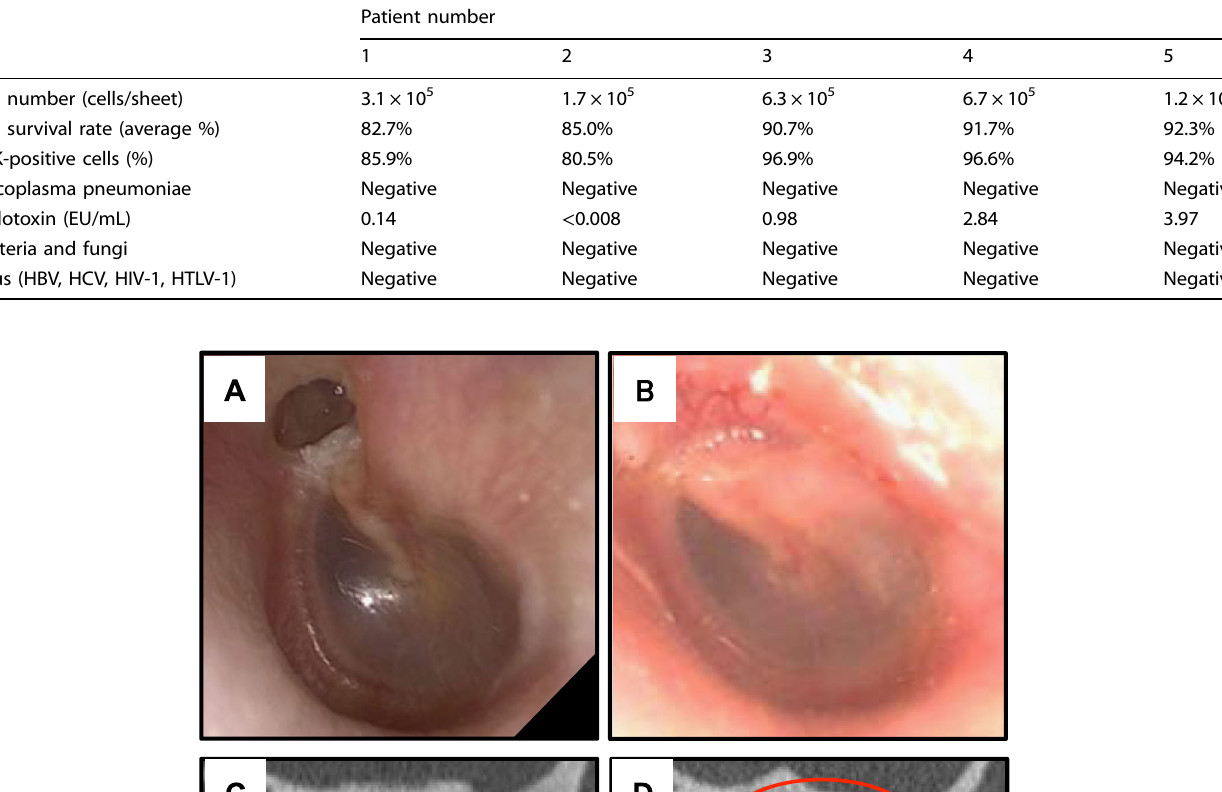
Table 2. Results of the quality control tests of cell sheets one day before transplantation